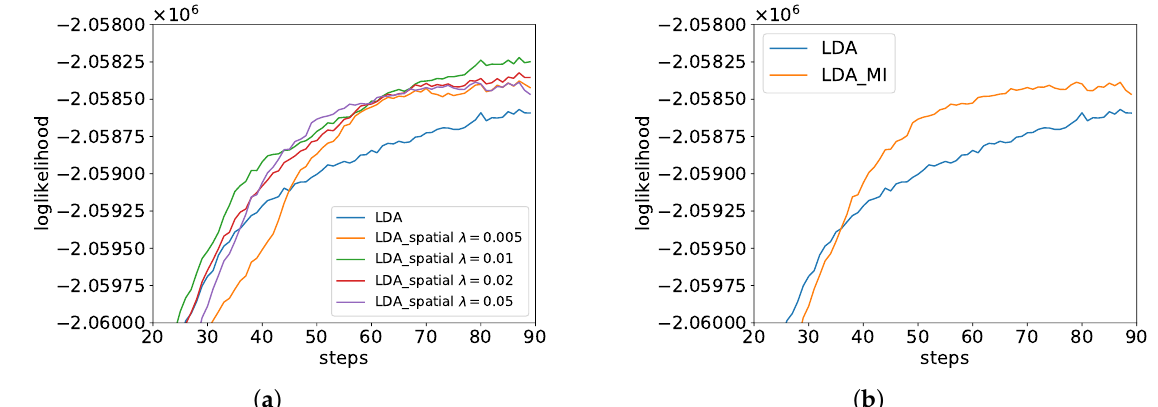
Figure 9. ( a ) log-likelihood for LDA with or without spatial coherence; ( b ) log-likelihood for LDA with or without MI